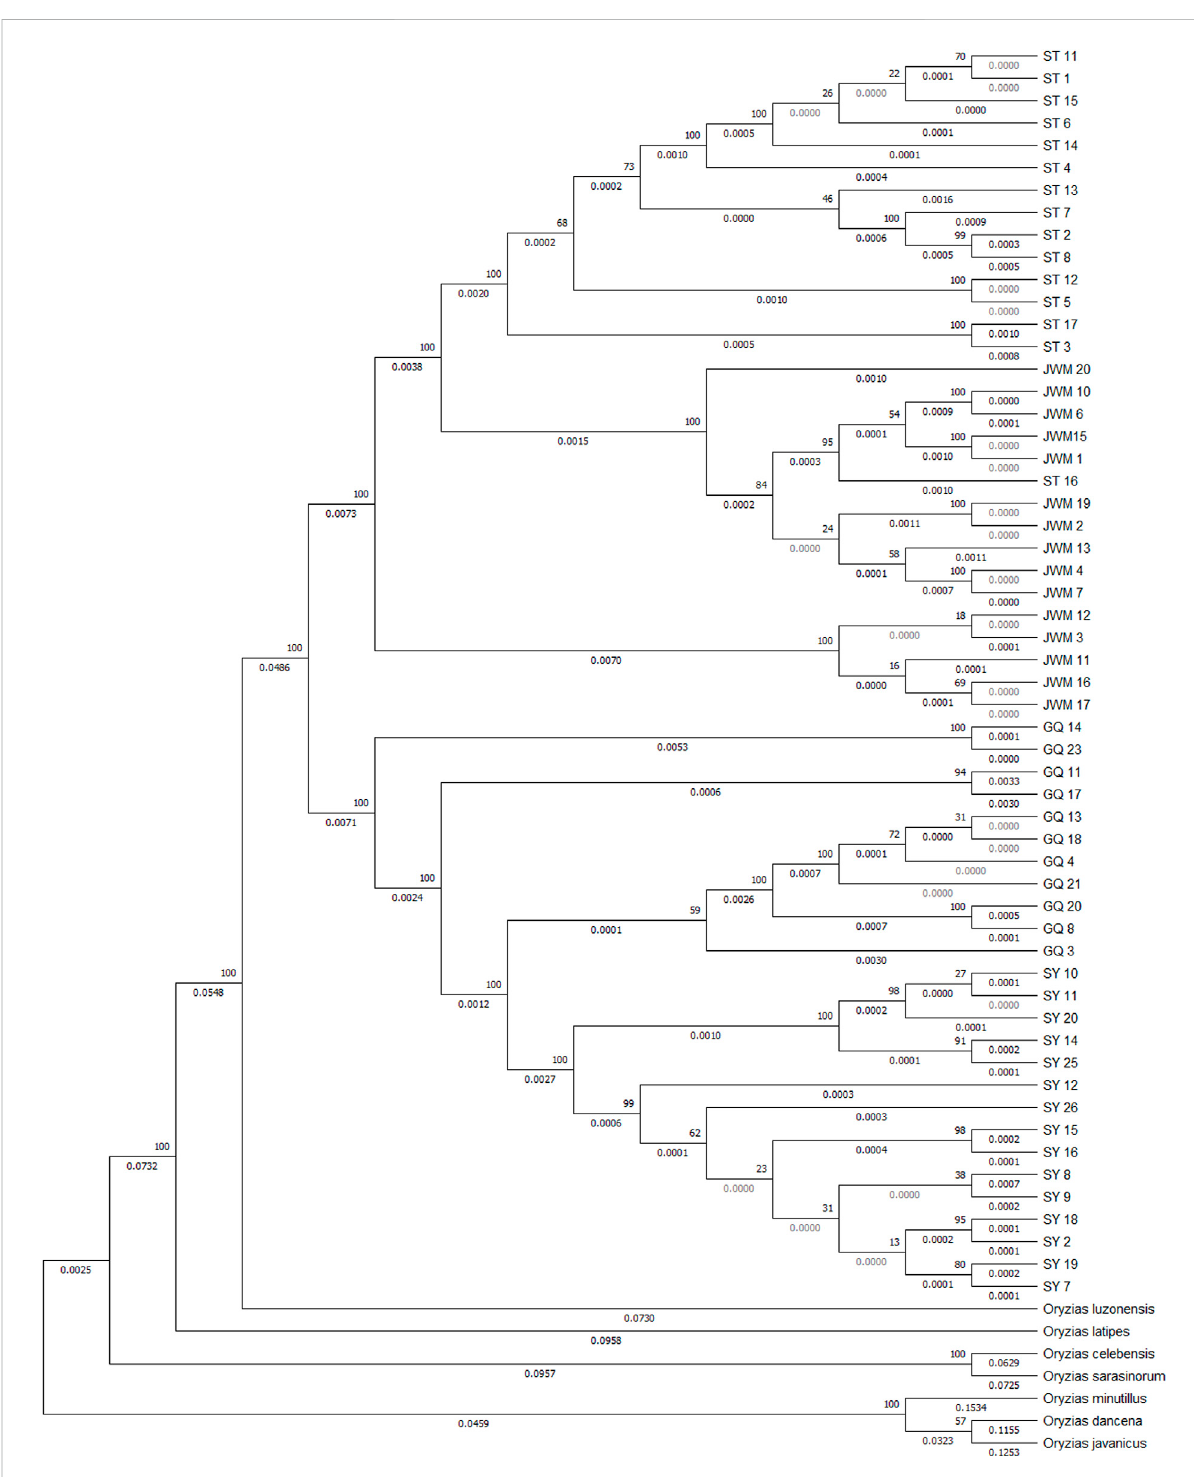
FIGURE 4 Based on the ML tree of mitochondrial whole sequences, some other fi sh of the Oryizas genus were used as outgroups. The bootstrap value (above branch) and branch lengths (below branch) are shown